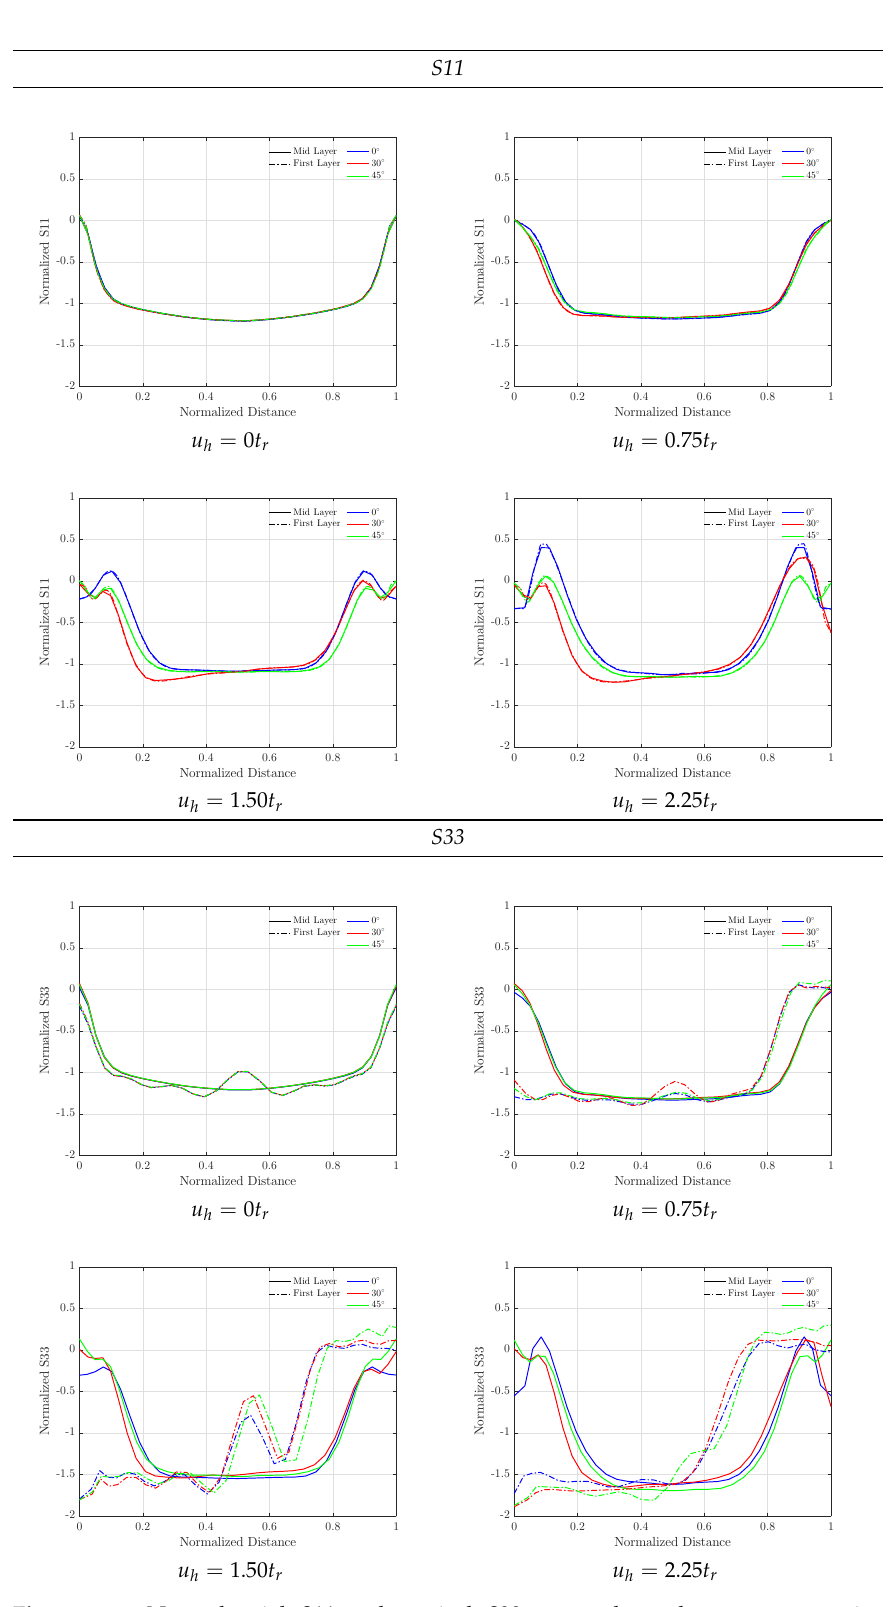
Figure 20. Normal axial S11 and vertical S33 stress along the symmetry axis. Effect of reinforcement